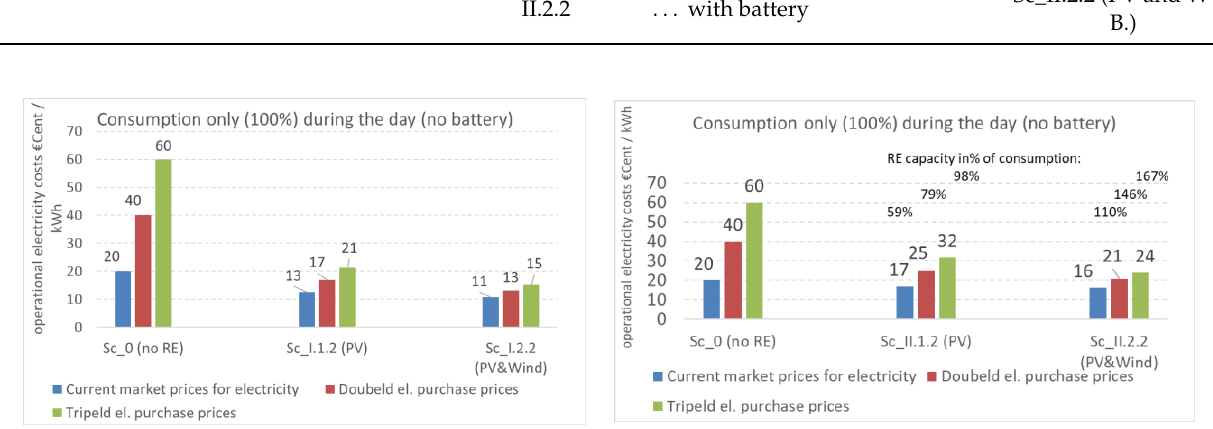
Figure 8. Cost of electricity for a farm with consumption only during the day (100% day) for status quo (0.20 ct/kWh) and when price is doubled or tripled, as well as investments in PV or PV and wind, showing batteries are not worth the investment: ( a ) Sc_I: with feed-in tariff according to RES Act (PV power 13 ct/kWh or wind power 5 ct/kWh) ( b ) Sc_II: without feed-in tariff for excess electricity (post-RESA).